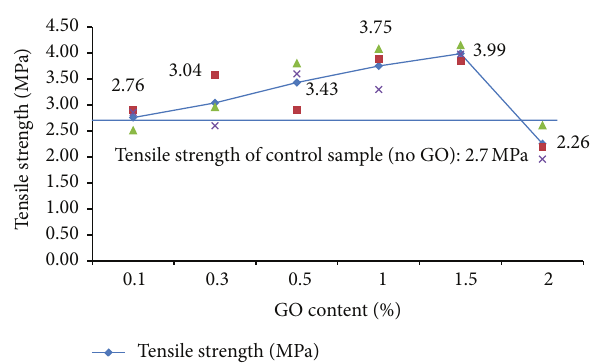
Figure 7: Tensile strength results of cement mortar specimens with graphene oxide content.